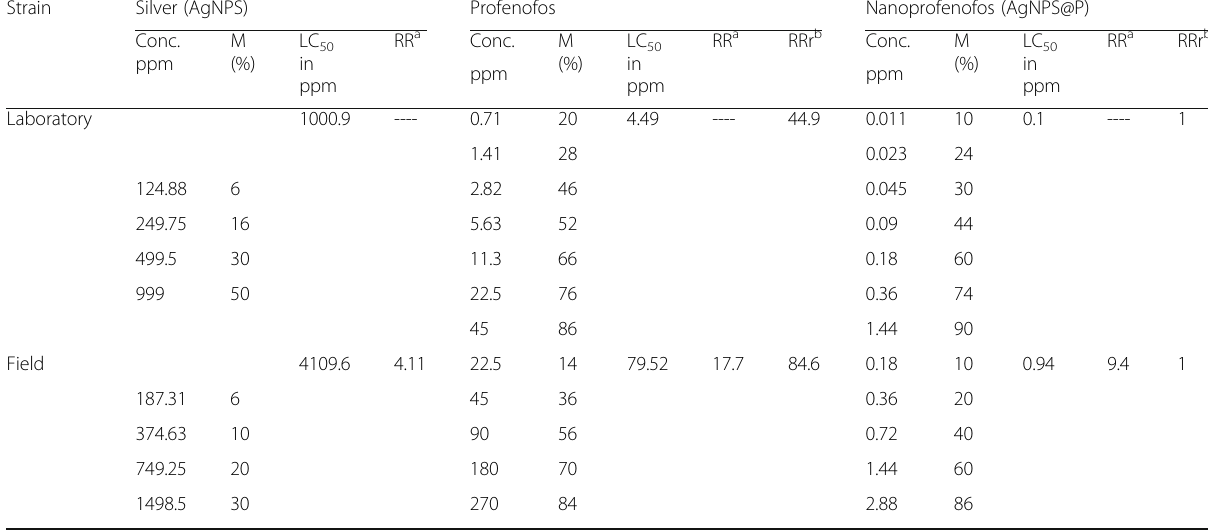
Table 1 Toxicity effect of silver nanoparticles (AgNPS) and profenofos compared with nanoprofenofos (AgNPS@P) against second- instar larvae of laboratory and field cotton leafworm, Spodoptera littoralis Strain Silver (AgNPS) Profenofos Nanoprofenofos (AgNPS@P) Conc.